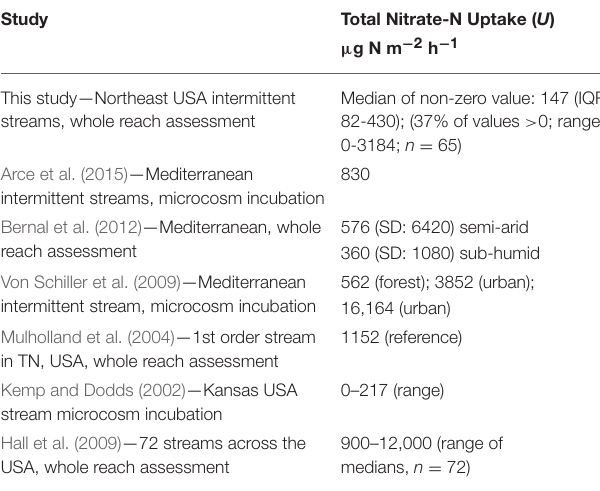
TABLE 5 | Total nitrate-N uptake ( U ) comparisons with other